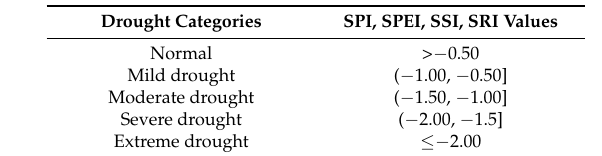
Table 2. Classification of drought